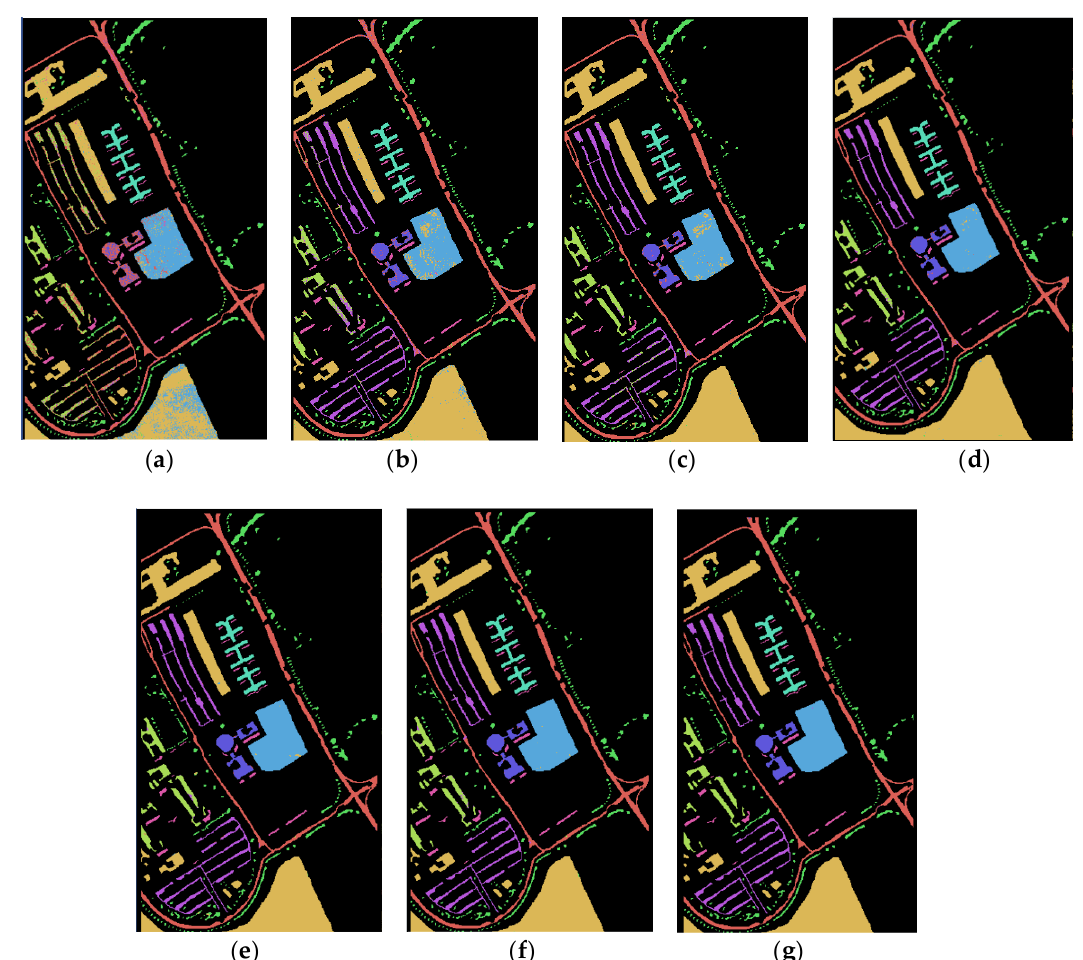
Figure 13. ( a – g ) Classification map of principal components analysis (PCA), support vector machine (SVM), 2D convolutional neural network (CNN), 3D-CNN, RES-3D, space–spectrum joint deep network (SSRN), and proposed on Pavia University dataset.